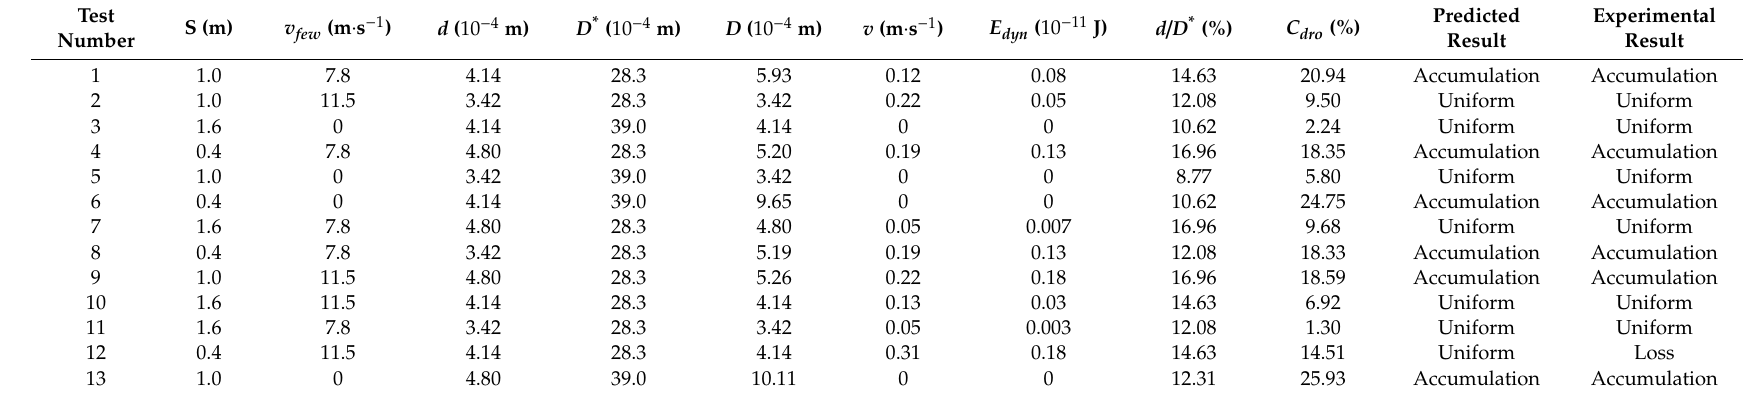
Table 2. Predicted and actual states of deposition of droplets on the reverse of Litchi leaves under di ff erent combinations of operating